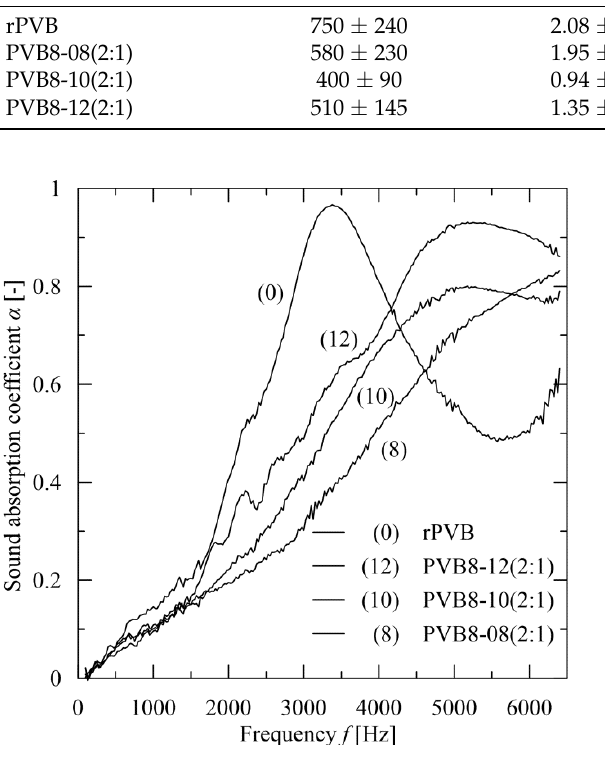
Figure 17. The courses of sound absorption coefficient α of chosen nanofibrous webs. Table 9. The values of sound characteristics for chosen nanofibrous webs.